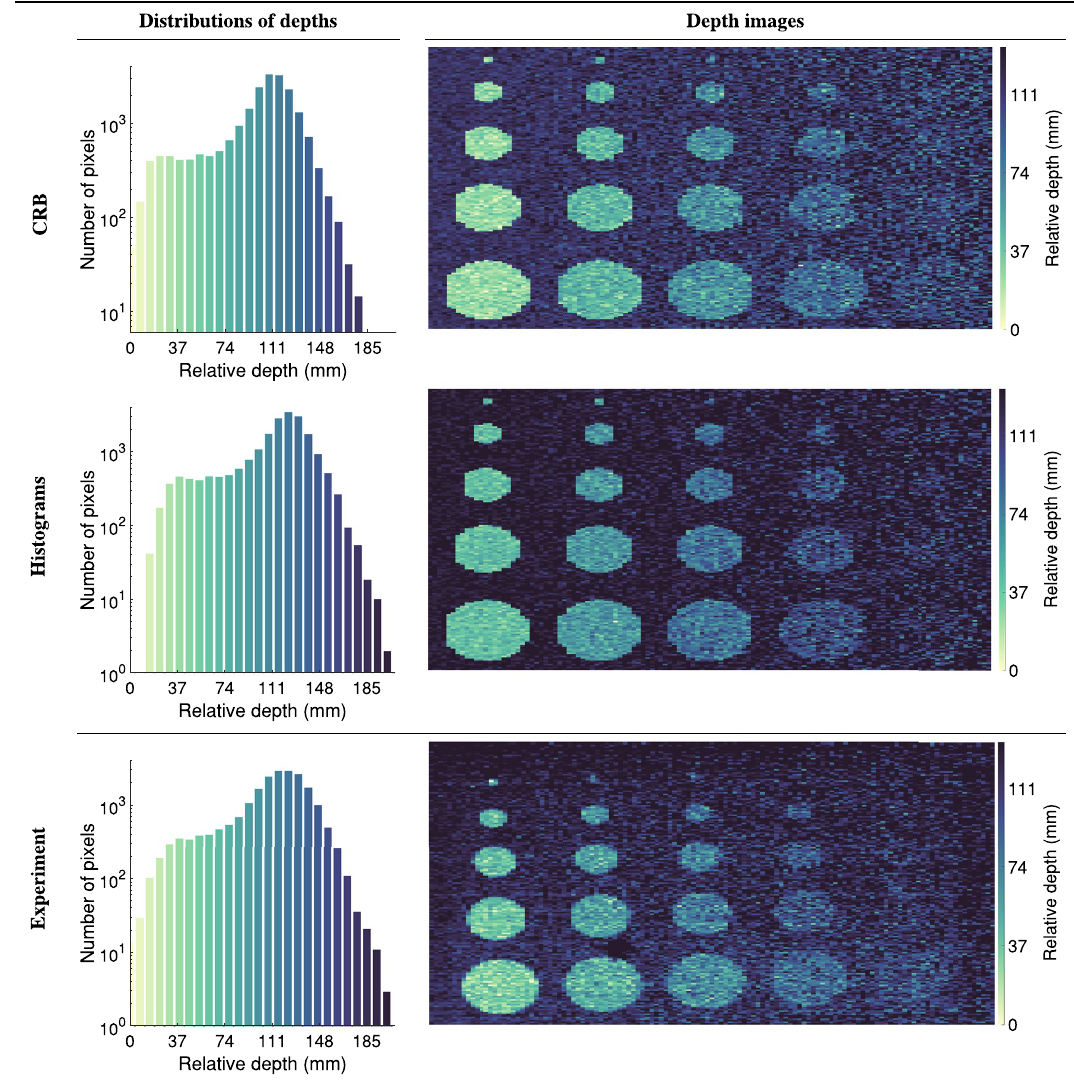
Figure 5. Quantitative and qualitative comparison between the simulated and measured depth images for the resolution test target. Left column, the number of pixels at a given depth as a histogram. Right column, the depth images. The first and second rows show the simulated images calculated using the Cramér-Rao bound approach and the histogram simulation approach respectively. The bottom row shows the experimental Figure 5 shows the simulated and measured depth images of the resolution test target accumulated over 1000 frames using an f2 collection lens. Each frame had a 1 ms duration resulting in 2250 laser pulses-per-frame. Additionally, Fig. 5 provides histograms showing the number of pixels at a given depth. The excellent qualitative agreement between the simulated and measured depth images demonstrates the ability of the model to accurately simulate SPAD data. The agreement is emphasised by the overlap between the depth histograms which have a median per bar accuracy in excess of 80%, meaning that under idealized lab conditions the simulation is able to predict the number of pixels at a given depth over an entire image with accuracies in excess of 80%. To create the images in Fig. 5 the peak of the histogram associated with each pixel was determined using match filtering (a.k.a cross correlation). Specifically, a Gaussian kernel was convolved with the histograms and the position of highest response taken as the depth. We selected match filtering as an estimator due to its prevalence within Lidar data processing. Additionally, it represents an unbiased (although possibly not minimum variance) estimator for the case of a single Gaussian peak with a uniform background. For further discussion, the reader is directed to supplementary materials 3. Whilst more advanced processing techniques exist for depth calculation 61 , we stress that the objective of this work was not to examine the efficacy of different image processing techniques but was rather to accurately simulate the data acquired by SPAD based imaging systems.